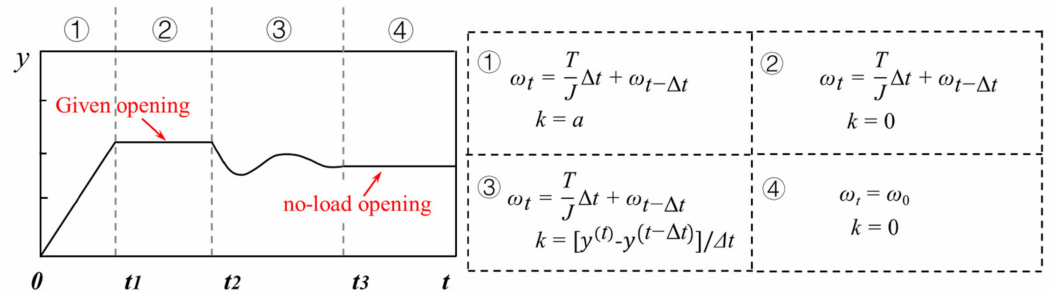
Figure 1. Variations of guide vane opening and rotational speed during the start-up process where ∆ t : timestep, s; ω t and ω t − ∆ t : rotational speeds of runner at the current and previous timesteps, respectively, rad/s; T : torque, N · m; k : opening/closing speed of guide vanes, rad/s; a: an invariant constant; y ( t ) , y ( t −(cid:52) t ) : guide vane openings at the current and previous timesteps, respectively, rad; ω 0 : rated rotational speed, rad/s, J : inertia of rotating parts, kg · m 2